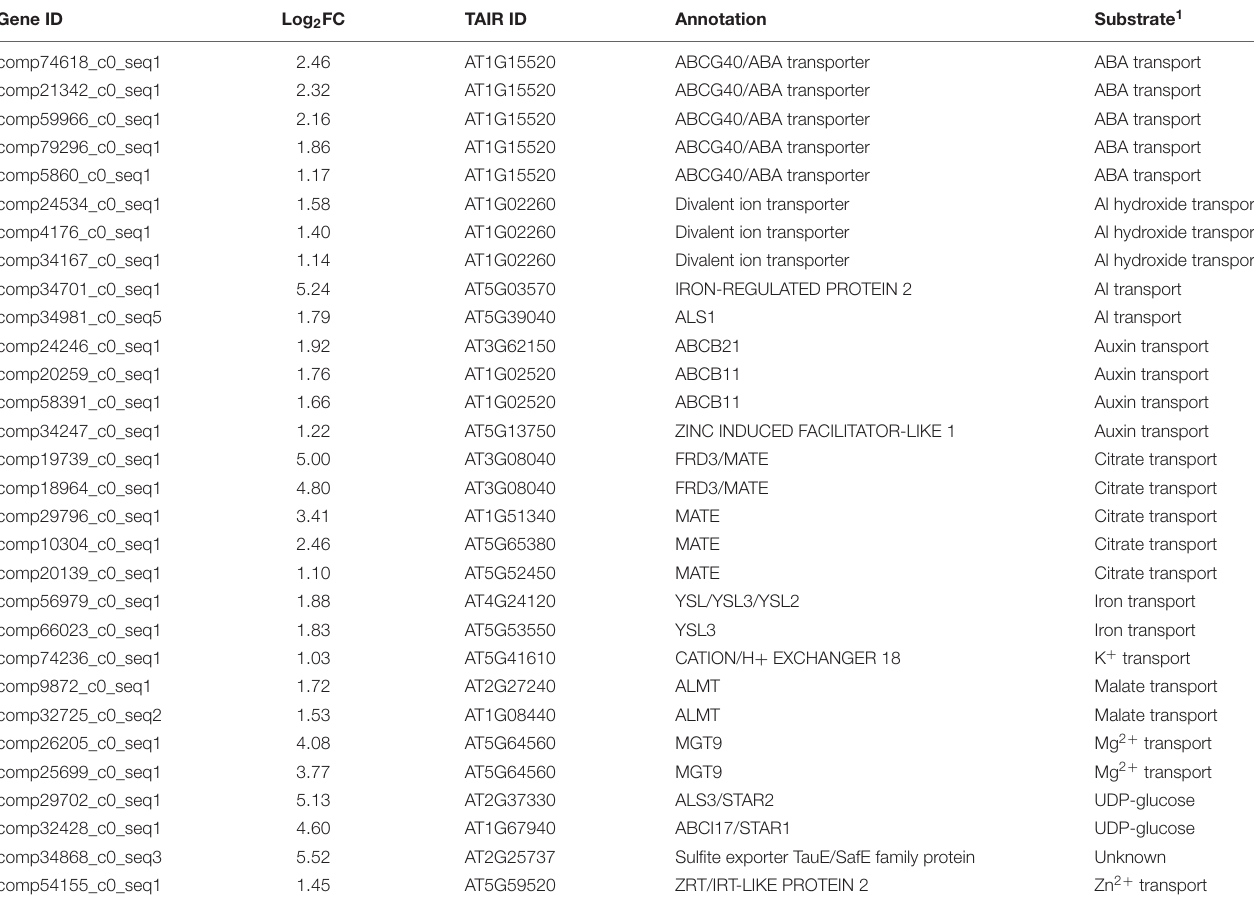
TABLE 3 | Al up-regulated genes encoding putative